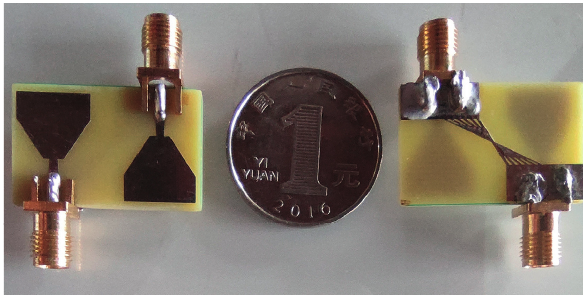
Figure 15: Fabricated image of the two-port UWB MIMO antenna.